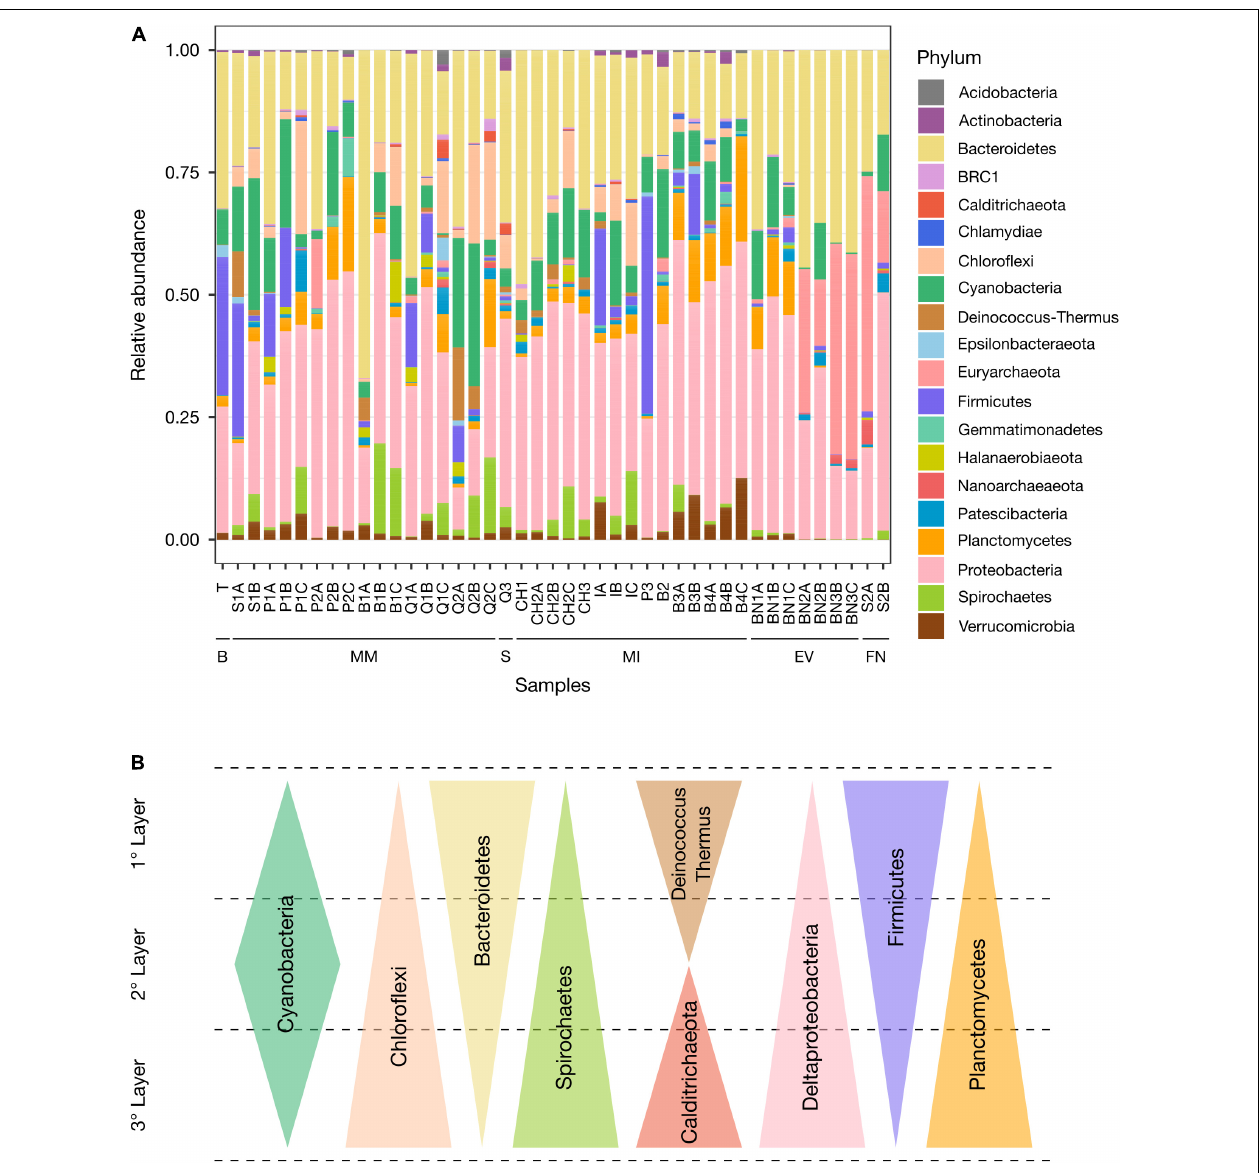
FIGURE 5 | Taxonomic composition of prokaryotes in the AMEs. (A) Relative abundance of the twenty major phyla in the different samples. B, Biofilm; MM, Microbial mat; S, Sediment; MI, Microbialite; EV, Endoevaporite; FN, Andean flamingo mound nest. (B) Graphical summary of taxa depth distributions observed in the microbial